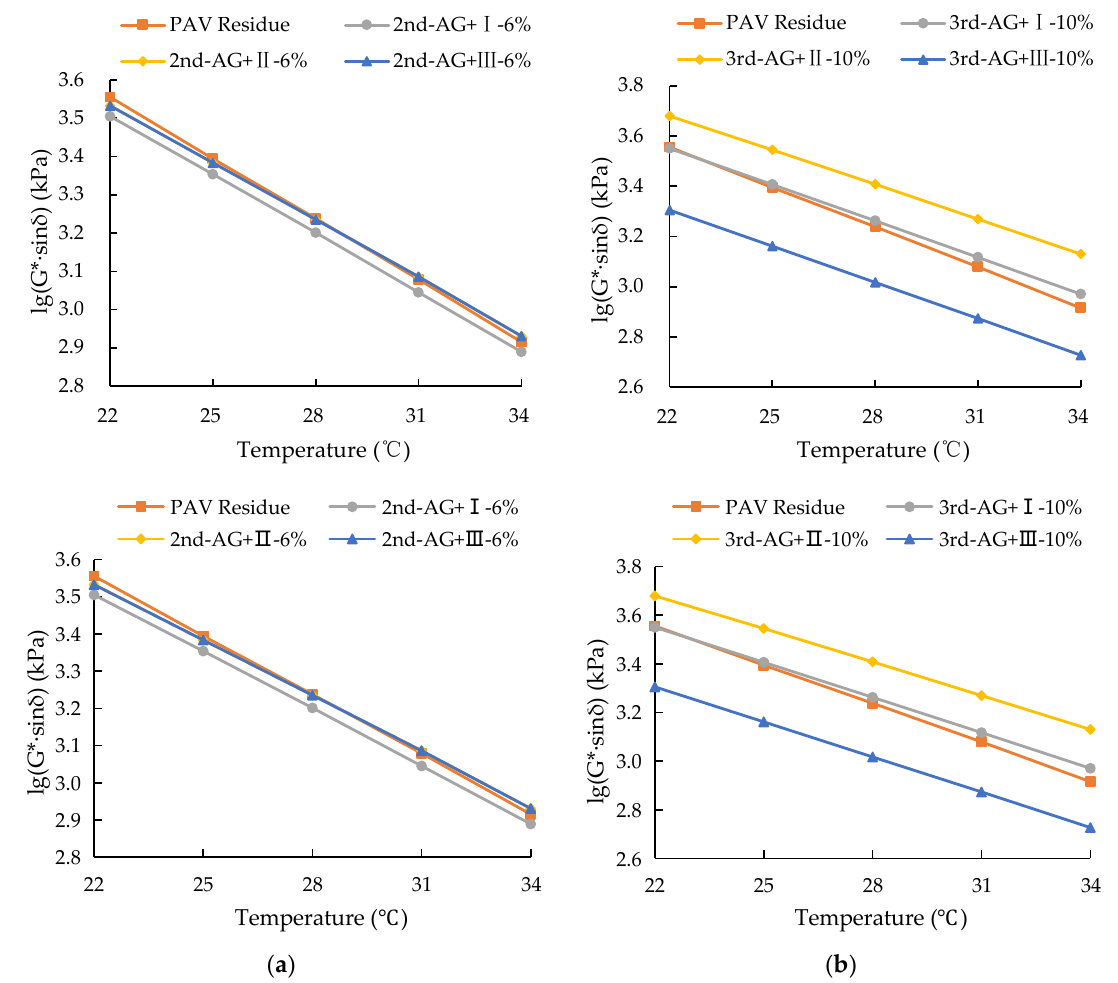
Figure 5. Fatigue factor of SBS asphalt-binders at different aging cycles: ( a ) Second cycle; ( b ) Third cycle.